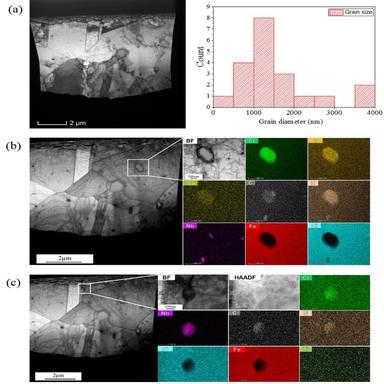
(a) Bright field TEM images showing low mag. grain morphology in alloy 709 subjected to a tensile test at 900 C. (b) EDX maps showing (Cr, Mn, Mo)-rich carbides and (c) Nb-rich carbon-nitride observed at the boundary of newly formed grains.